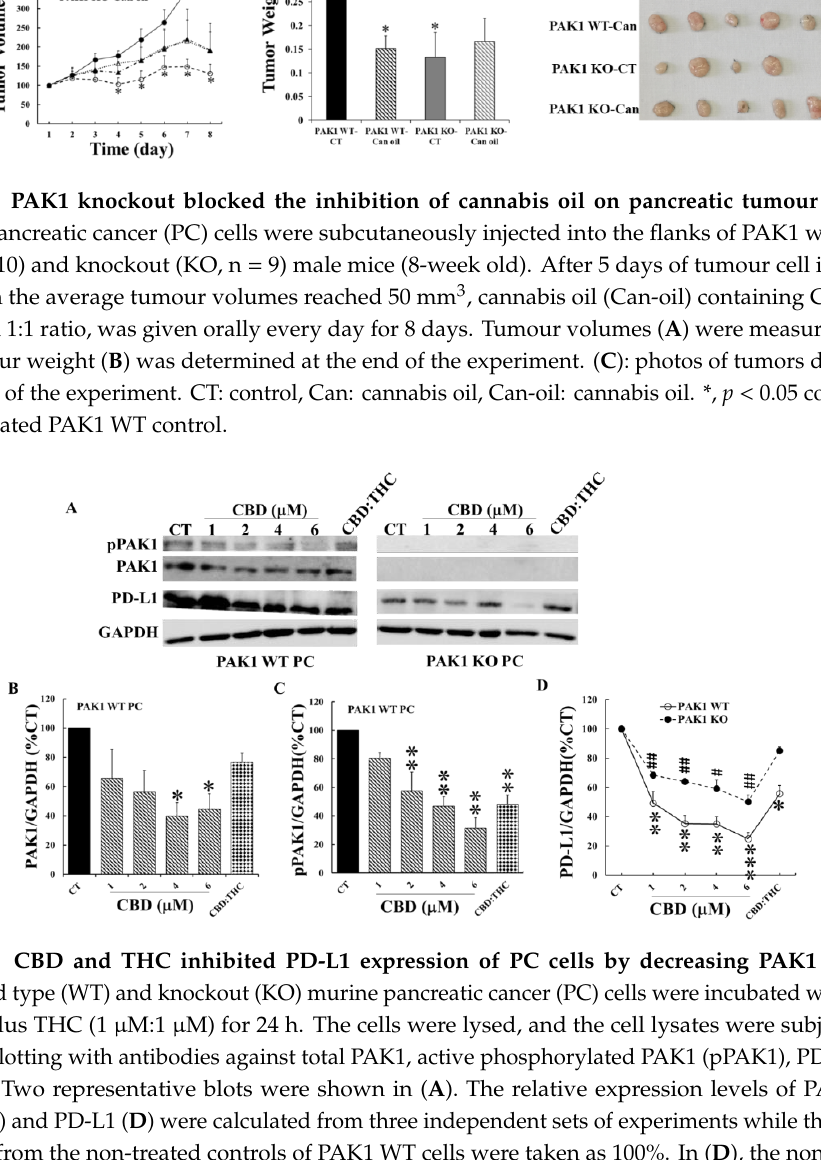
Figure 3. PAK1 knockout blocked the inhibition of cannabis oil on pancreatic tumour growth. Murine pancreatic cancer (PC) cells were subcutaneously injected into the flanks of PAK1 wild type (WT, n = 10) and knockout (KO, n = 9) male mice (8-week old). After 5 days of tumour cell injection and when the average tumour volumes reached 50 mm 3 , cannabis oil (Can-oil) containing CBD and THC with 1:1 ratio, was given orally every day for 8 days. Tumour volumes ( A ) were measured daily and tumour weight ( B ) was determined at the end of the experiment. ( C ): photos of tumors dissected at the end of the experiment. CT: control, Can: cannabis oil, Can-oil: cannabis oil. *, p < 0.05 compared to non-treated PAK1 WT control.